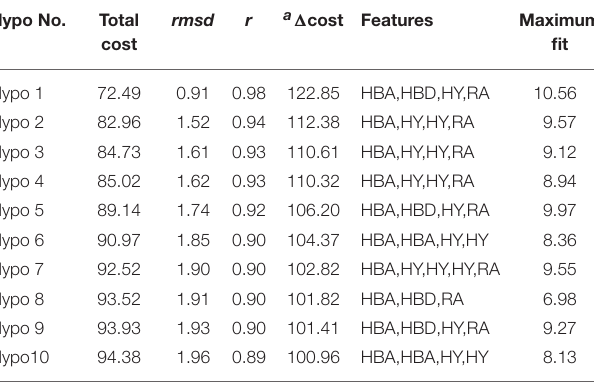
TABLE 1 | Parameters of top pharmacophore hypotheses computed by HypoGen algorithm a . Hypo